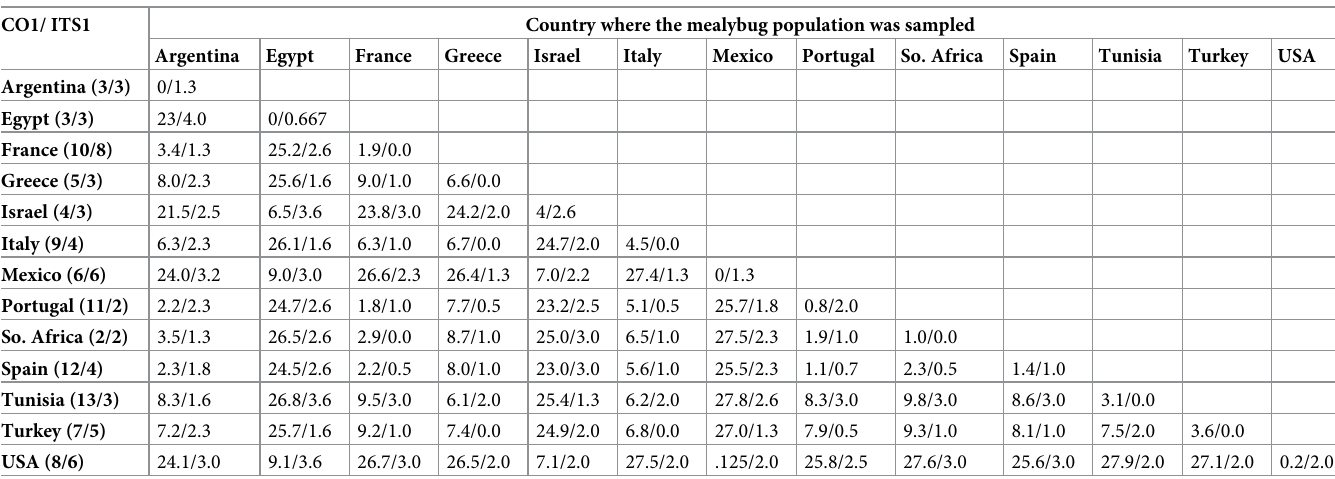
Table 1. DNA sequence variation.